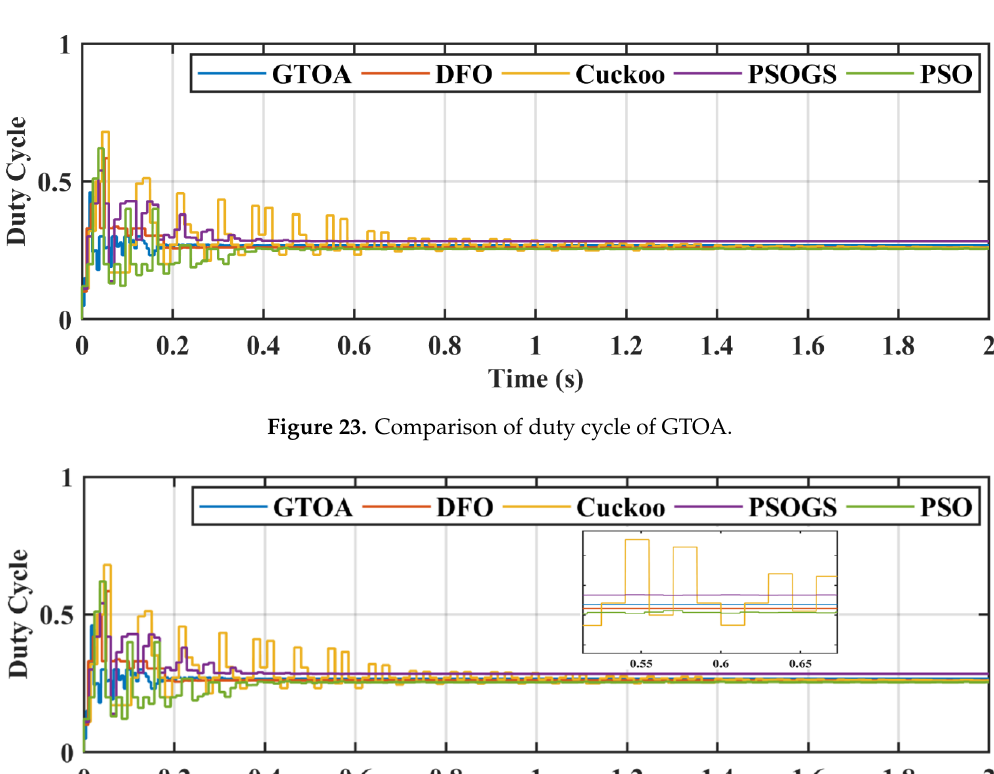
Figure 22. Zoomed-in comparison of power of GTOA.